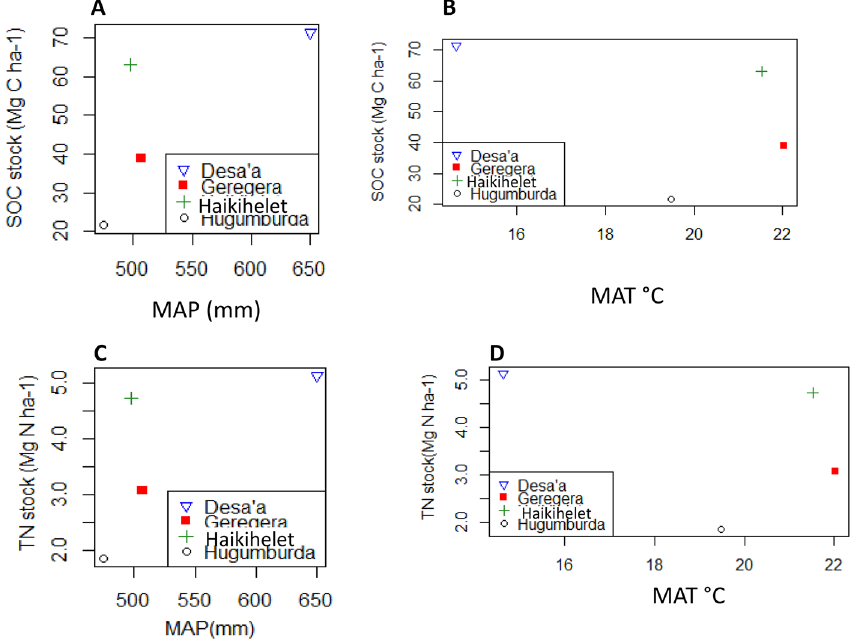
Figure 6. Linear relationship between soil carbon stock (Mg C/ha) and ( A ) mean annual precipitation (MAP); ( B ) and mean annual temperature (MAT); and total nitrogen stock (Mg N/ha) and ( C ) mean annual precipitation (MAP); ( D ) and mean annual temperature (MAT); ( p ≤ 0.05, n =